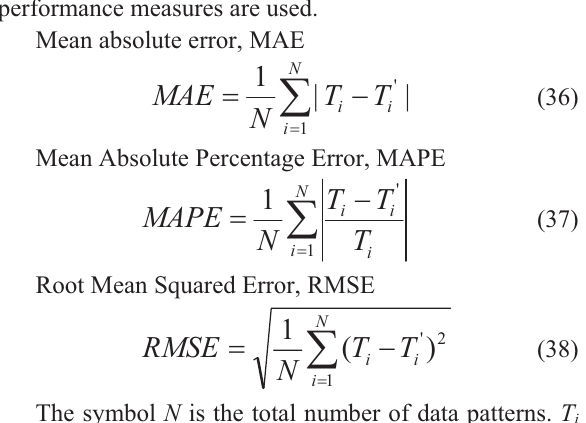
=0.5, P =0.9, P =0.02, and c,min c,max m,min